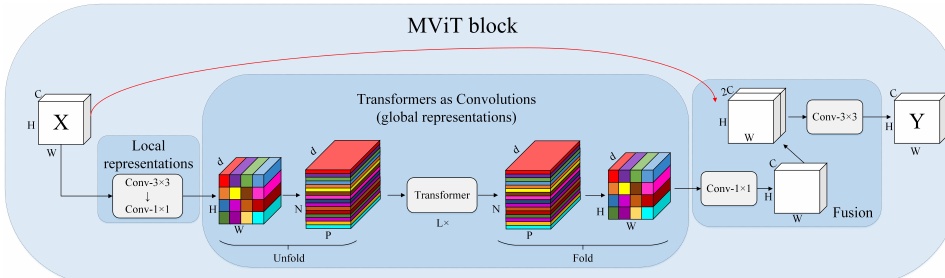
Figure 3. The structure of MVIT